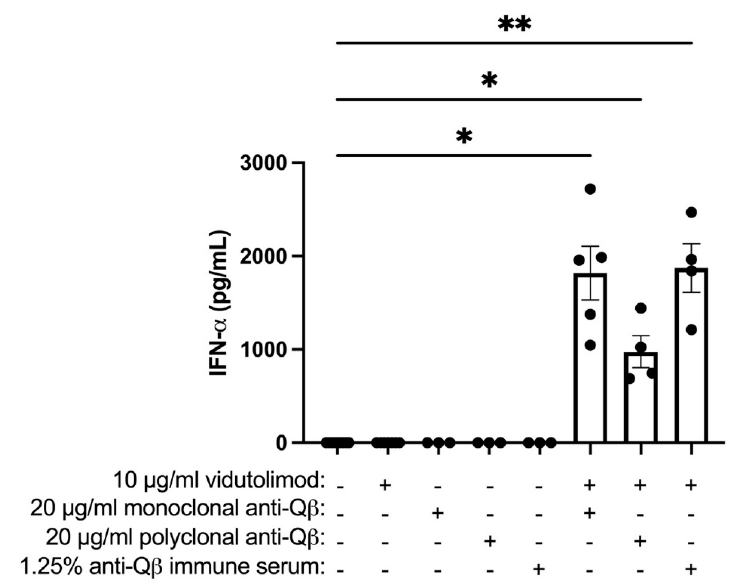
Figure 3. Human anti-Q β -coated vidutolimod induces Type I Interferon production. Unfractionated PBMCs were treated with vidutolimod plus or minus anti-Q β antibody or anti-Q β immune serum and supernatant tested for IFN α by ELISA. Graph depicts means +/ − SEM. Statistical significance was determined using mixed-effects analysis with multiple comparisons test with alpha = 0.05 ( n = 3–5; * p < 0.05; ** p < 0.01).